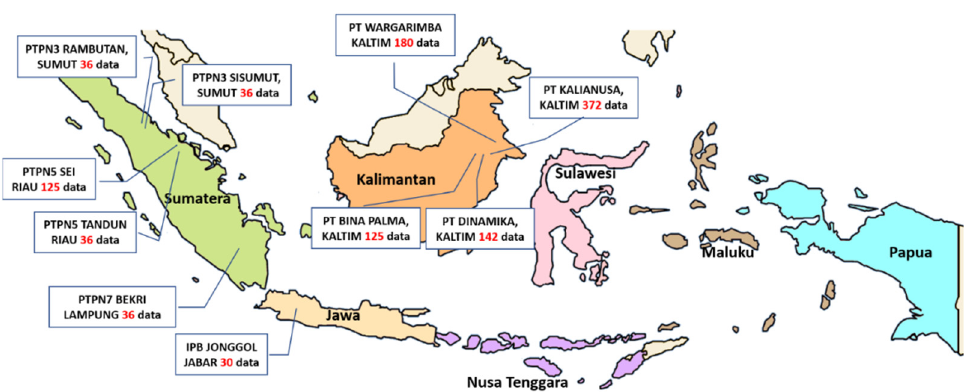
Figure 4. Map of Leaf Sampling Unit (LSU) locations in Sumatra, Java, and Kalimantan.